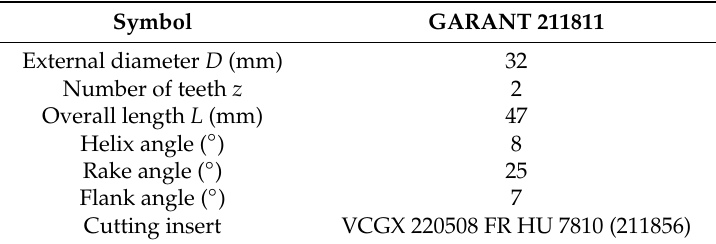
Table 4. Specification of milling cutter